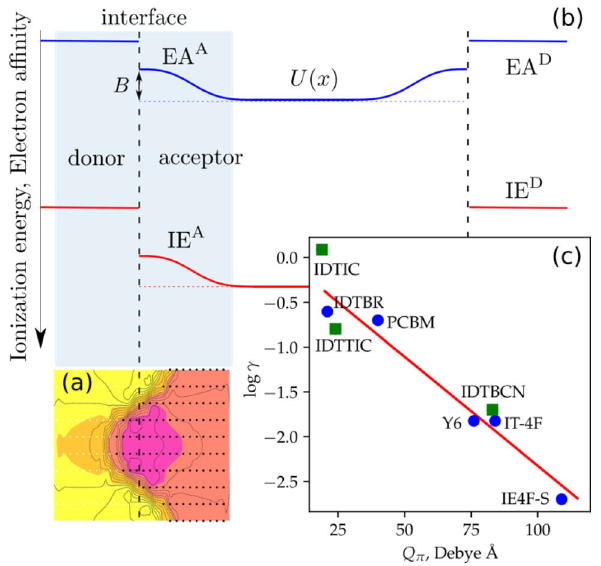
Figure 3.. ( a ) 2D map of the electrostatic potential energy surface for a charge interacting with quadrupoles of surrounding neutral molecules (one period of a periodic interface is shown) ( b ) Energy level diagram with band bending in the acceptor phase. The bias potential B creates a barrier for charge recombination. ( c ) Logarithm of the Langevin reduction coefficient as a function of the π -component of the quadrupole tensor. Blue circles are data points obtained in this study, green squares represent Langevin reduction factors obtained from the literature 57,58